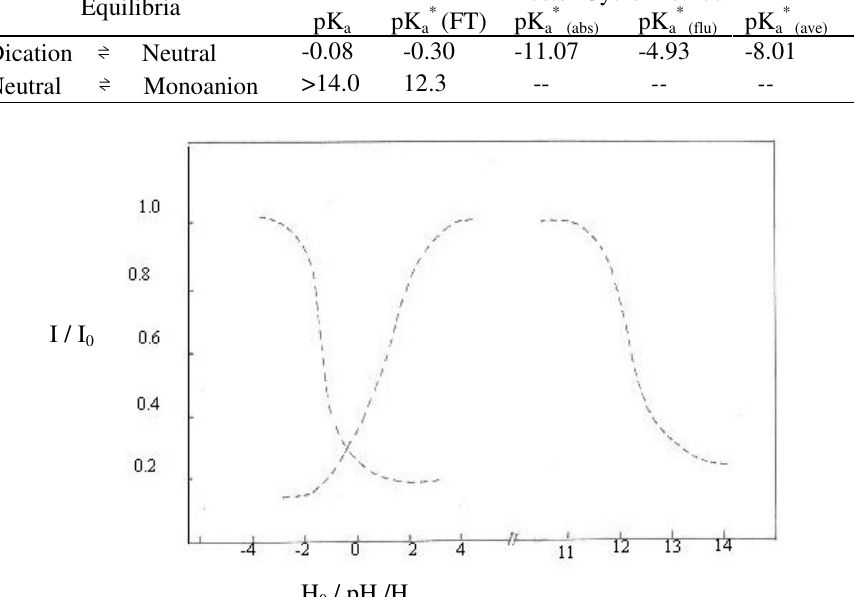
Figure 4 . Plot of relative fluorescence intensities (I/Io) Vs H o /pH/H- of the various prototropic species of